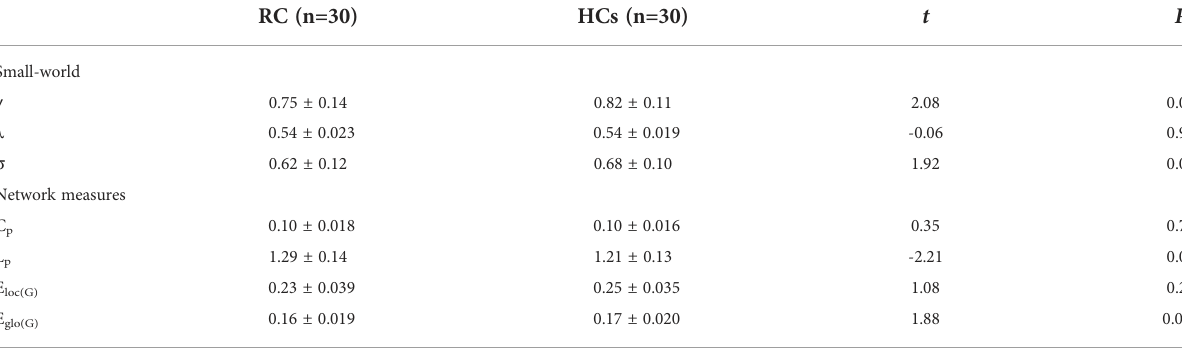
RC, rectal cancer; HCs, healthy controls. AUC,area under curve. g , normalized clustering coef fi cient; l , normalized characteristic path length; s , small-worldness. C p , clustering coef fi cient of network; L p , characteristic path length of network; E loc(G) , local ef fi ciency of network; E glo(G) , global ef fi ciency of network. Uncorrected P values were obtained by the method of two sample t-tests. P<0.05 indicated statistically signi fi cant